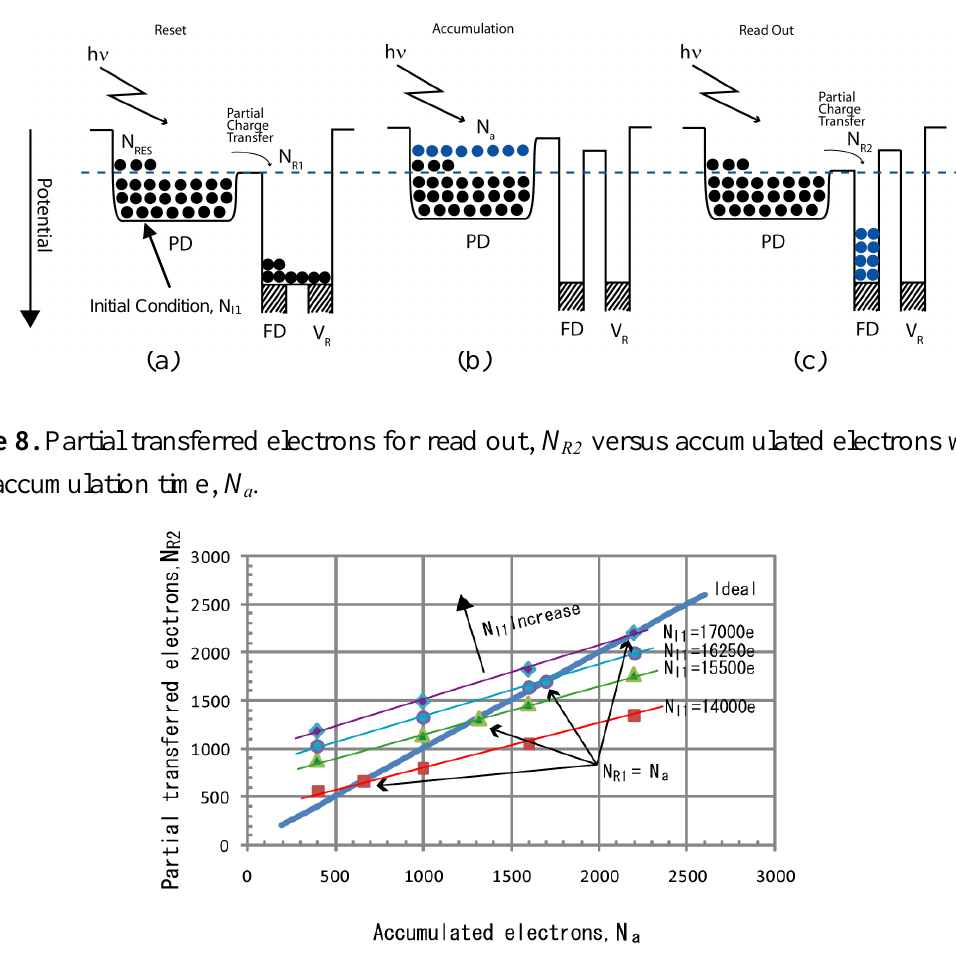
Figure 7. Initial condition influents the read out signals in partial transfer technique.